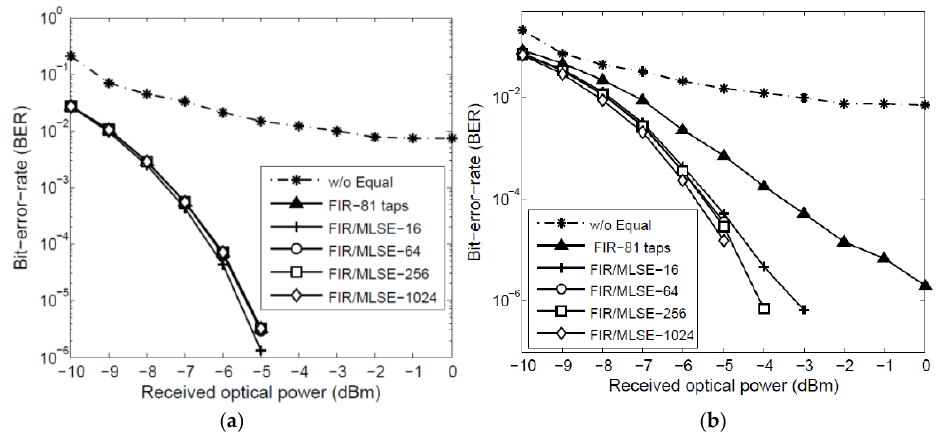
Figure 3. 56 Gb/s four-level pulse amplitude modulation (PAM-4) BER vs. received optical power for the back-to-back case when no equalization is employed (dashed line), when only an FIR filter is employed (triangles), and when an FIR followed by an 16-, 64-, 256-, and 1024 states MLSE equalizer is employed at the receiver (crosses, circles, squares, and diamonds, respectively). ( a ) When a four-level MMA and ( b ) when a seven-level MMA is used for FIR taps convergence (conditions: Experimental setup of Figure 1b).